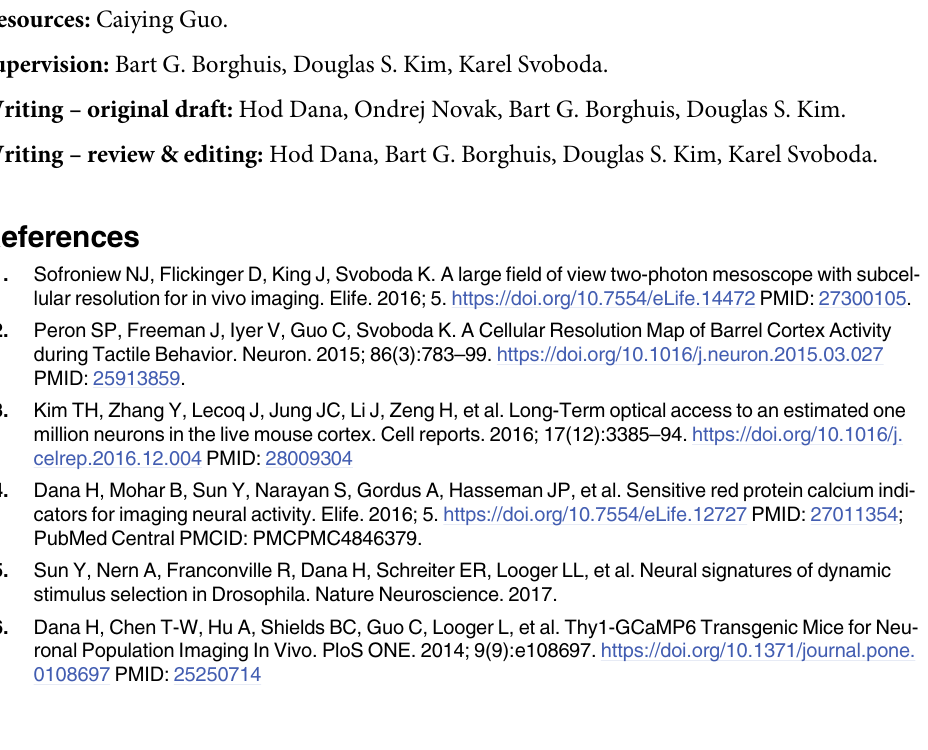
values for Thy1 -jRGECO1a and AAV-jRGECO1a, showed in panel a , and summarized in panel b , indicates that the tuning of the measured cells was not disturbed ( Thy1 -jRGECO1a, 1725 cells from 8 mice; AAV-jRGECO1a, 472 cells from 4 mice). S1 Data. Widefield images of all characterized GP lines. Images of all characterized GP lines were taken using a slide scanner (Methods). All imaging conditions were kept identical, except for lines GP8.20, GP8.31, GP8.58, and GP.8.62, where the light intensity was reduced to 1/3 of its level with the other lines. Sections are organized from rostral to caudal on the slides, each slide direction is from top to bottom, and the slides are organized from left to